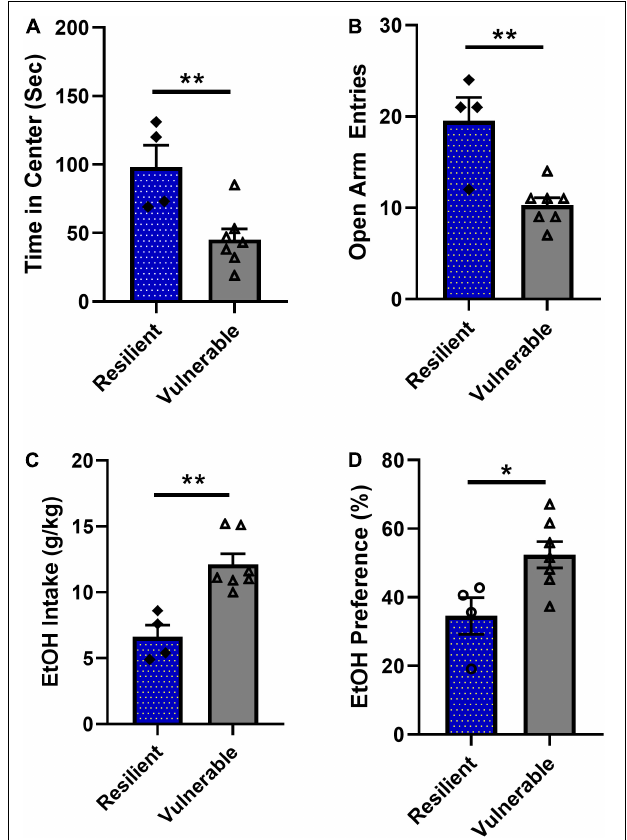
FIGURE 7 | Behavioral phenotype of rats classified as resilient ( N = 4) or vulnerable ( N = 7). (A) Vulnerable rats spent significantly less time in center during the open field test compared to the resilient group ( **P < 0.01). (B) Vulnerable rats had significantly lower numbers of open arm entries during elevated plus maze testing (** P < 0.01). (C) Vulnerable rats consumed significantly more ethanol than resilient rats during weeks 6–8 (** P < 0.01). (D) Vulnerable rats had significantly higher ethanol preference during weeks 6–8 compared to the resilient group (* P < 0.05). Data are expressed as means ± SEM and analyzed by two-tailed t -test.